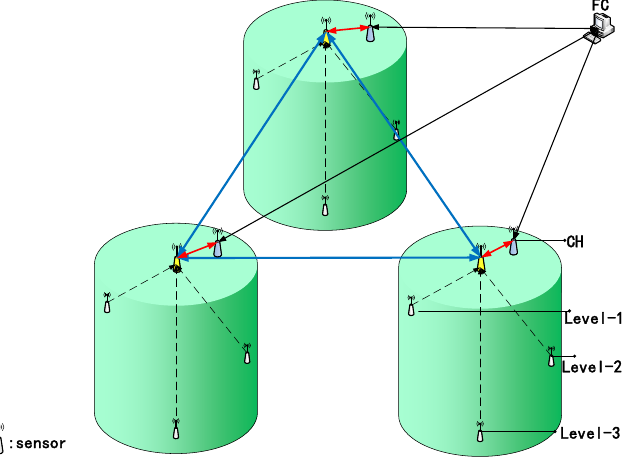
Figure 5. Hierarchical data fusion framework for clustered multi-connected sensor networks.